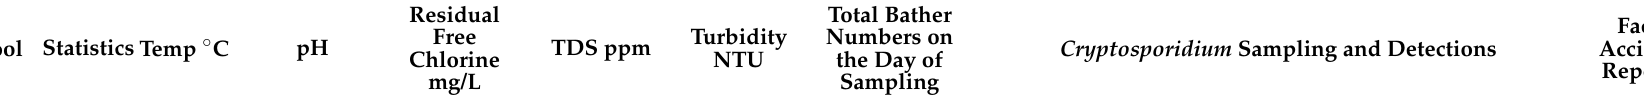
Table 3. Summary of Cryptosporidium oocyst occurrence in pool water and backwash samples, aerobic colony counts and physical-chemical properties of volunteer leisure pools from weekly sampling over 10 weeks from 8 August